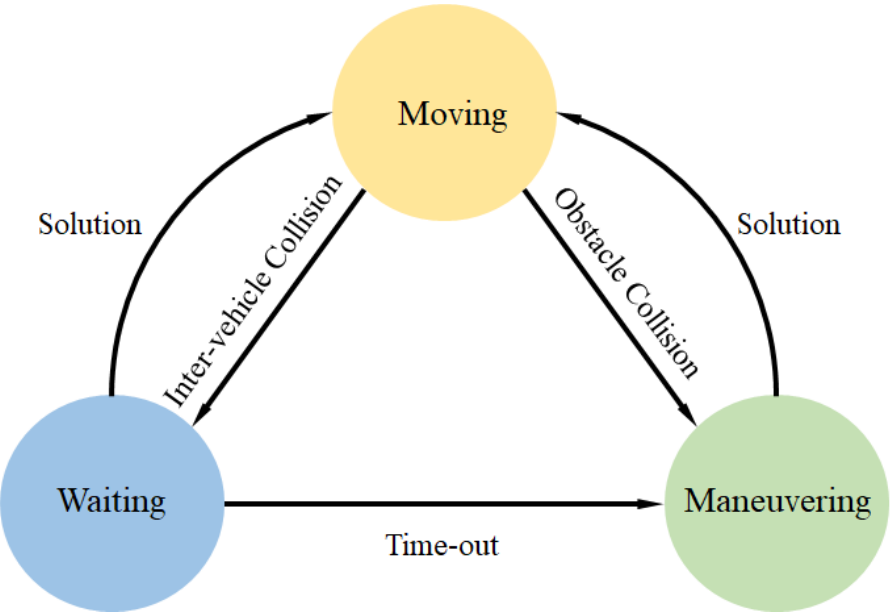
Figure 1. State switching under different